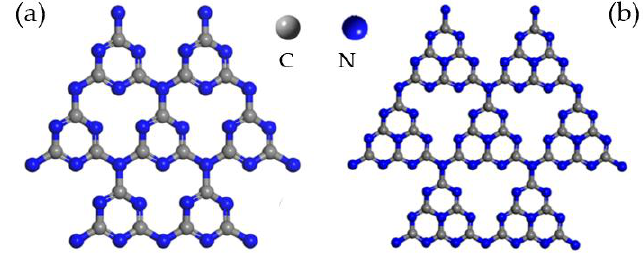
Figure 1. Structures of ( a ) triazine and ( b ) tri-s-triazine. Reprinted with permission from Ref. [25]. Copyright 2021 American Chemical